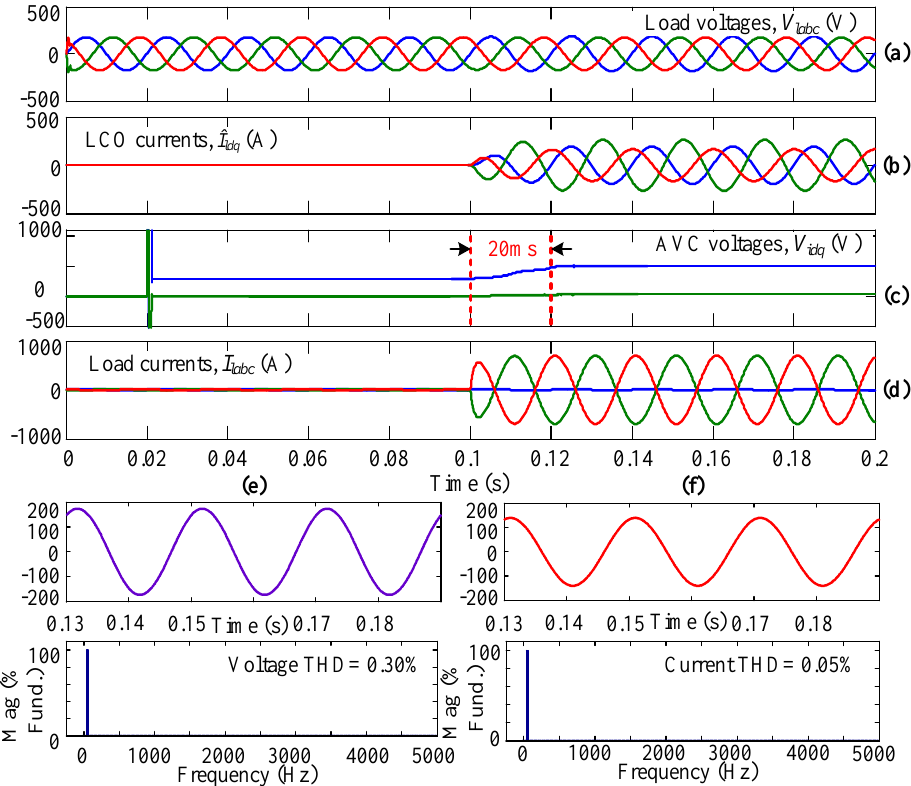
Figure 12. Simulation results for case-IV with unbalanced load condition.